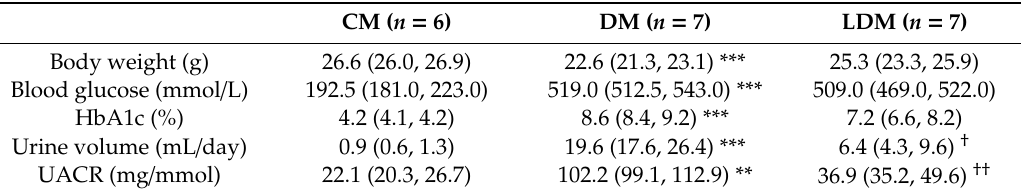
Table 1. Baseline characteristics of control mice (CM), STZ-induced diabetic mice (DM), and losartan-treated diabetic mice